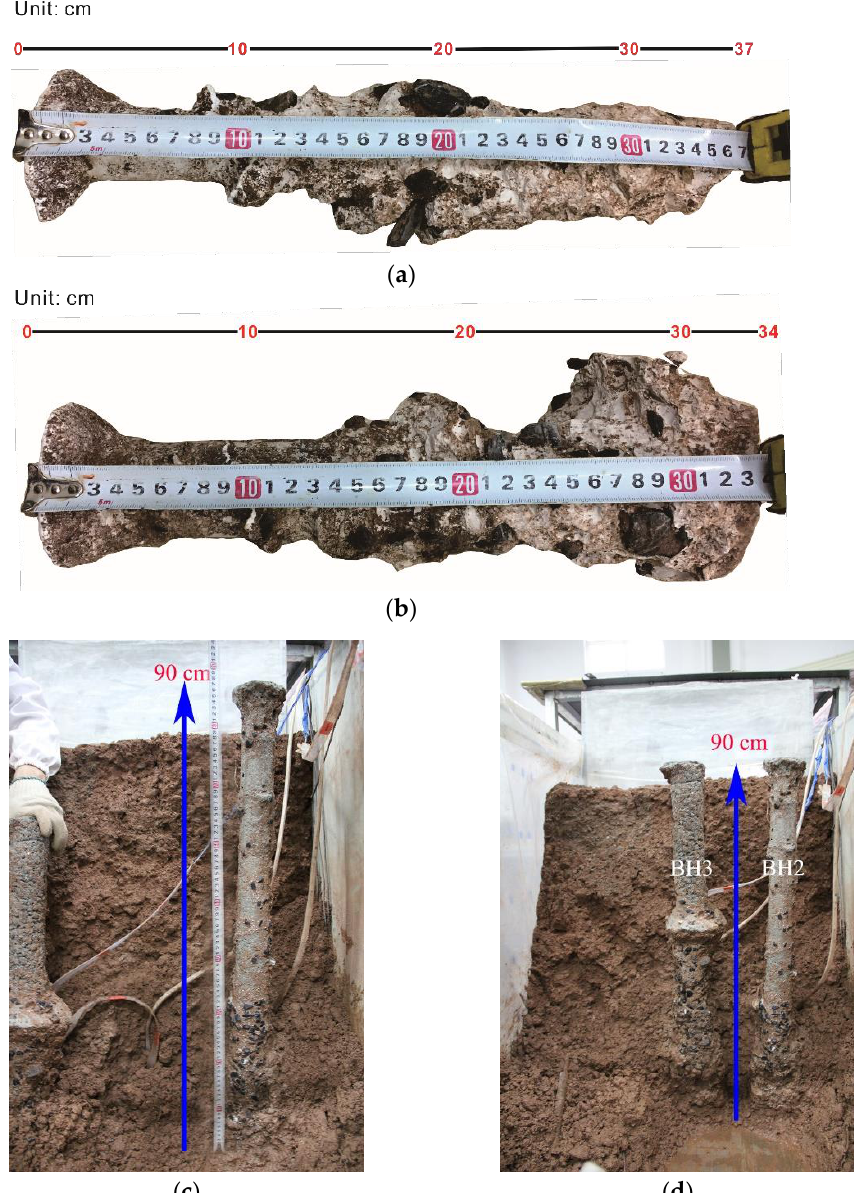
Figure 10. Cast in place pile formed after drilling with clean water and polymer fluid: ( a ) pile in BH2 formed by using water: ( b ) pile in BH3 formed by using water; ( c ) pile in BH2 formed by using polymer fluid; ( d ) pile in BH3 formed by using polymer fluid.